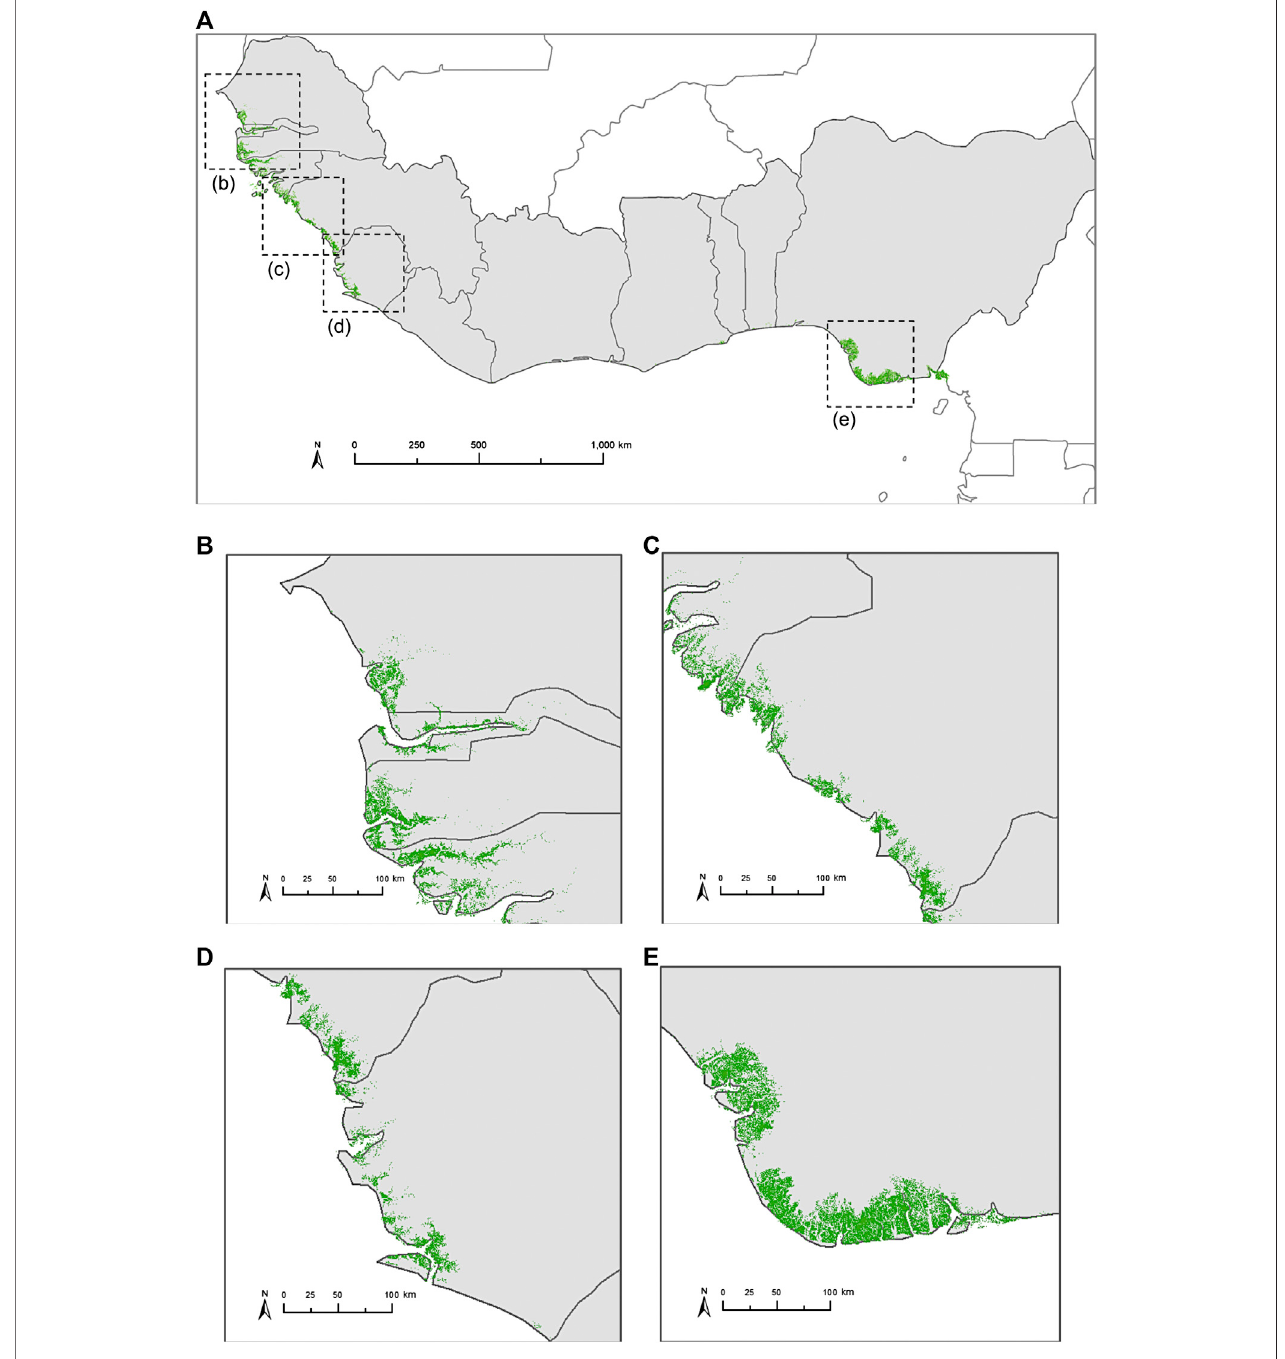
FIGURE 3 | 2017 mangrove extent map at 20 m resolution created by the ensemble of RF, GBM and NN for the West Africa coast based on the combination of Sentinel-2 multispectral data and Sentinel-1 C-band SAR data: (A) The entire West Africa, (B) Senegal and The Gambia, (C) Guinea, (D) Sierra Leone, and (E) Nigeria.